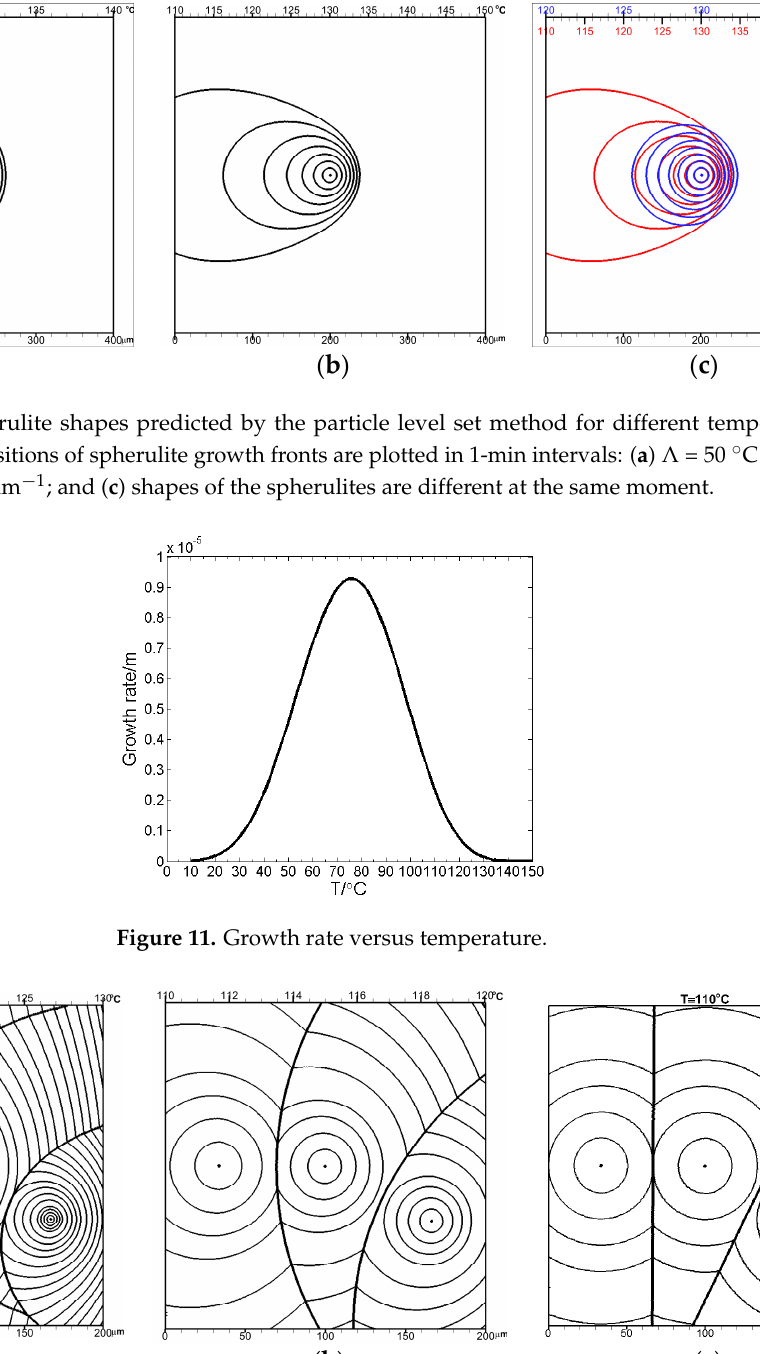
Λ Λ = 100 °C·mm − 1 ; ( b ) = 50 °C·mm − 1 ; and ( c )